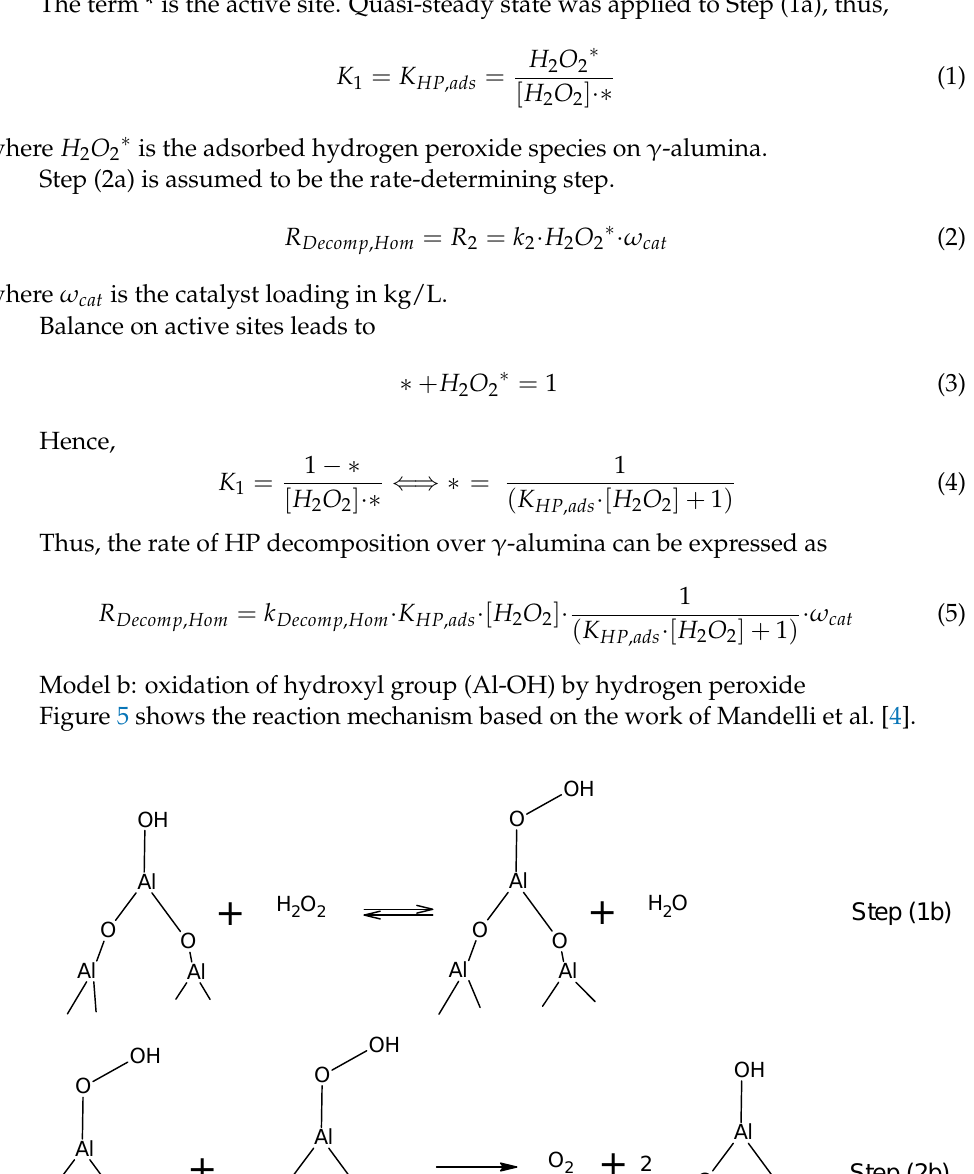
Figure 4. Reaction mechanism of hydrogen peroxide decomposition via HP adsorption.